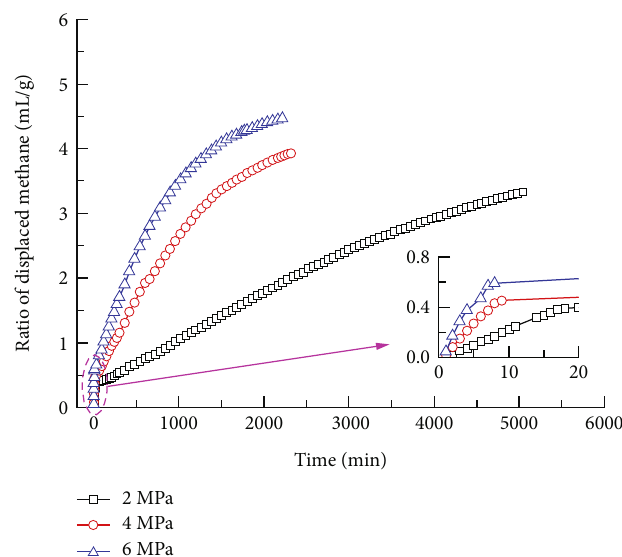
Figure 3: Ratio of displaced methane under di ff erent water injection pressures.